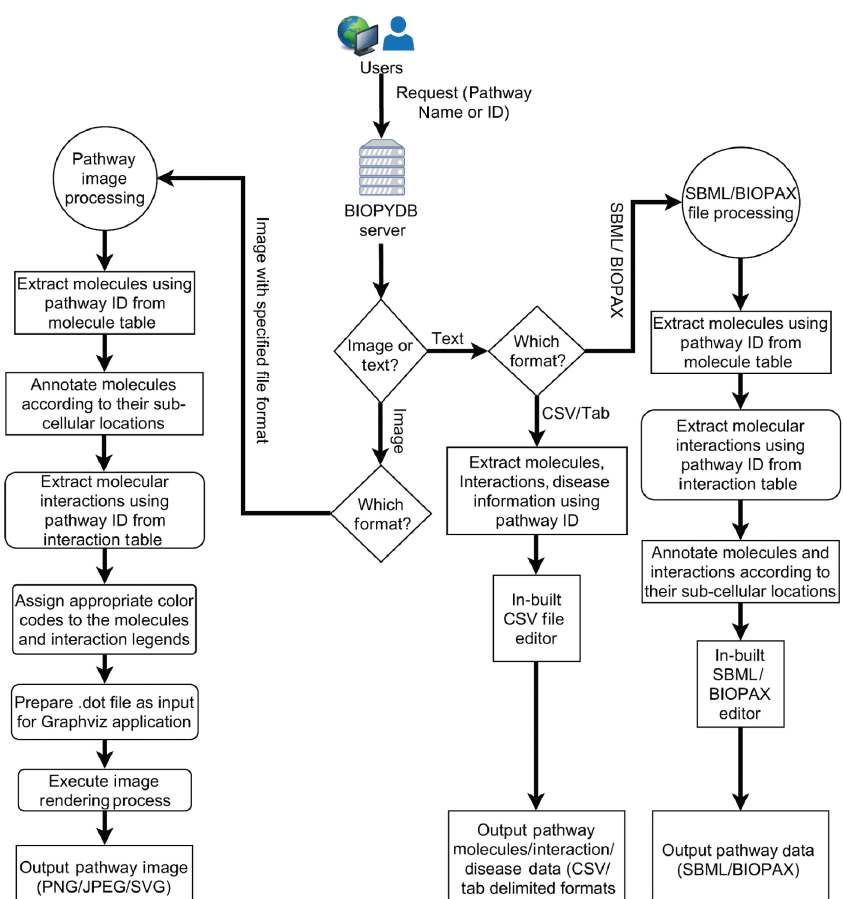
Figure 3: Flowchart depicting the process of pathway image construction and textual data preparation in the back-end of database